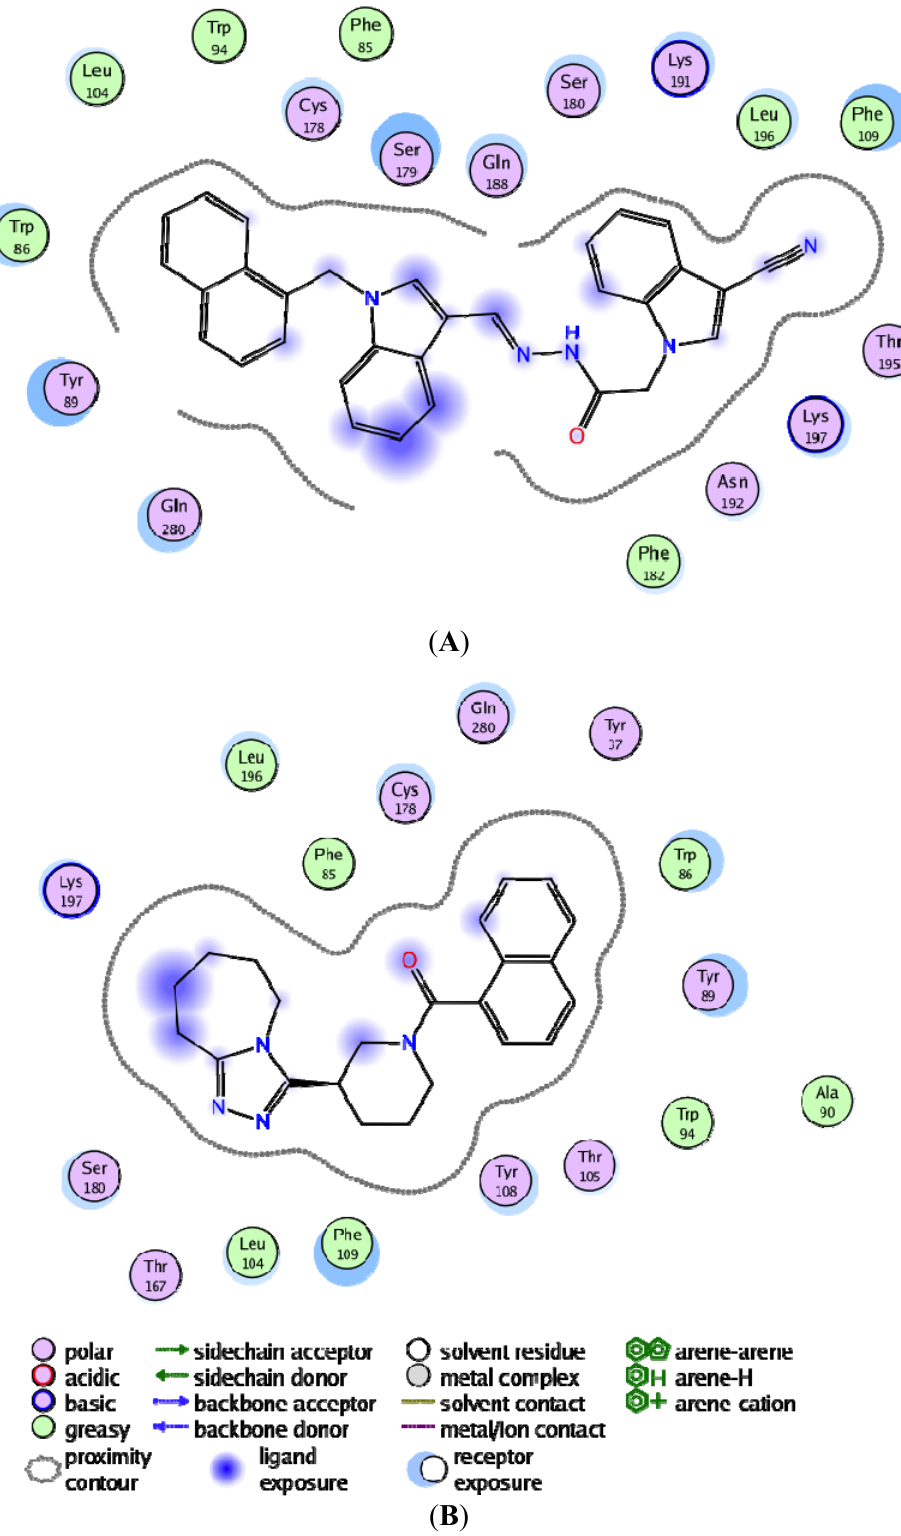
Figure 11. Pharmacophore-based compound (ZINC00634884) with CCR5 ( A ) and Structure-based compound (ZINC71849459) in complex with CCR5 ( B ), respectively, showing the hydrogen bonding and electrostatic interactions with the enzyme’s active site using